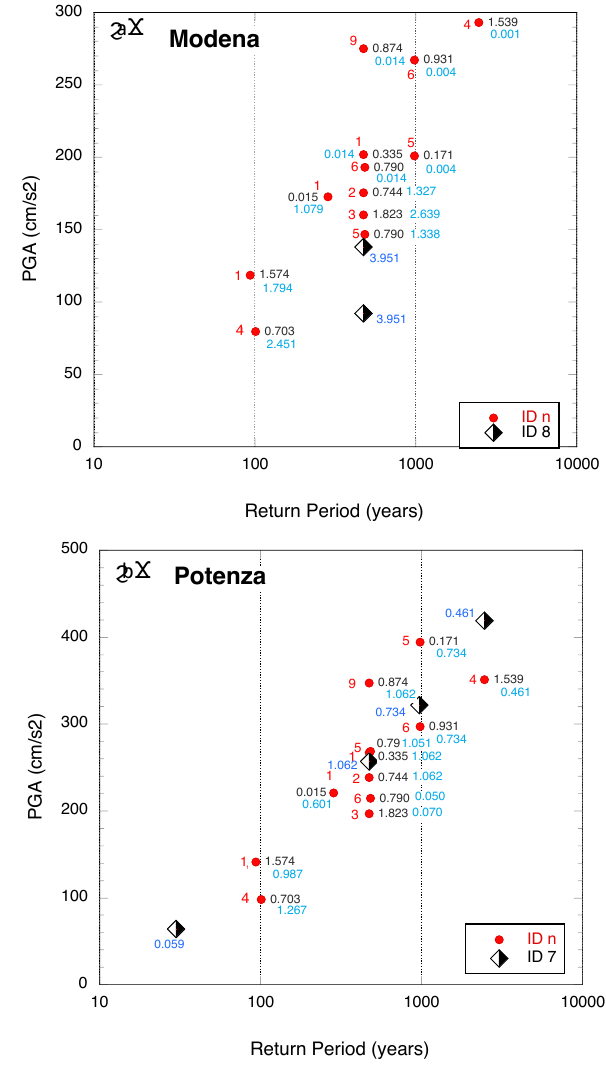
Figure 10. PSHA and scores at two selected sites. (a) Modena, in the Po Plain; (b) Potenza in the southern Apennines. Red dots and b/w diamonds represent the national and regional models, black and blue labels respectively the absolute Z values (Eq. 3) on the whole set and regional subsets of